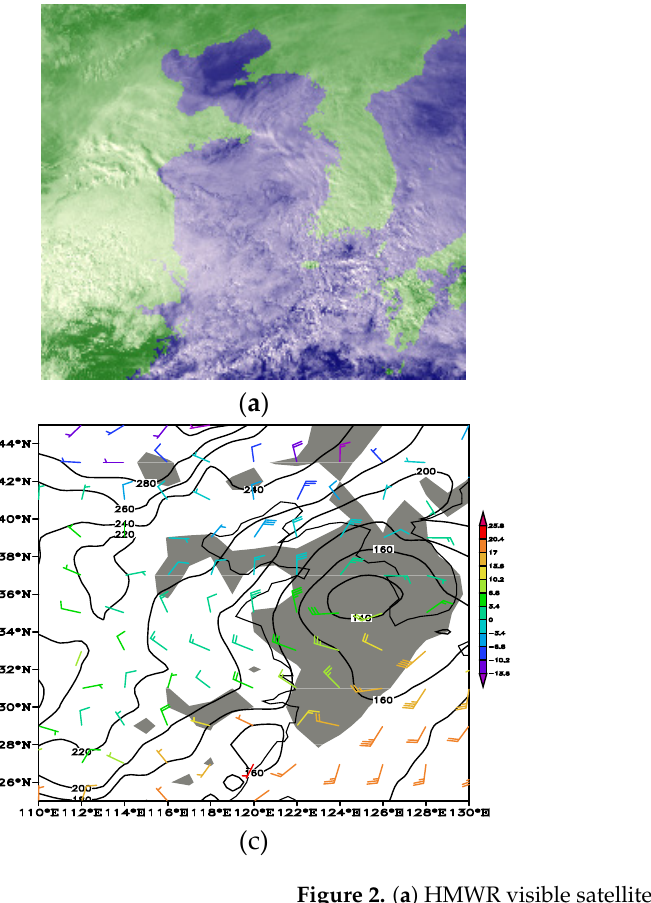
Figure 2. ( a ) HMWR visible satellite imagery at 06UTC 21 January 2013; ( b ) observation and simulation visibility at stations 58573 and 54646; ( c ) the distribution of height, temperature, and wind field at the 1000 hPa level; ( d ) sea–air temperature difference (unit: °C).